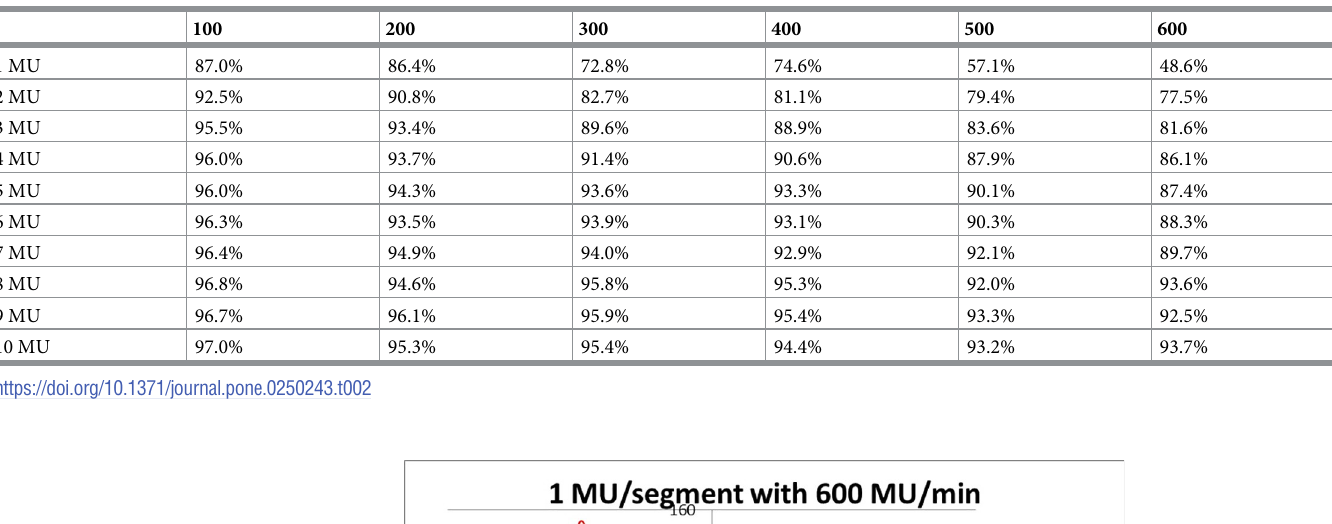
Table 2. Relative doses at the last segment in relation to the overshoot effect.